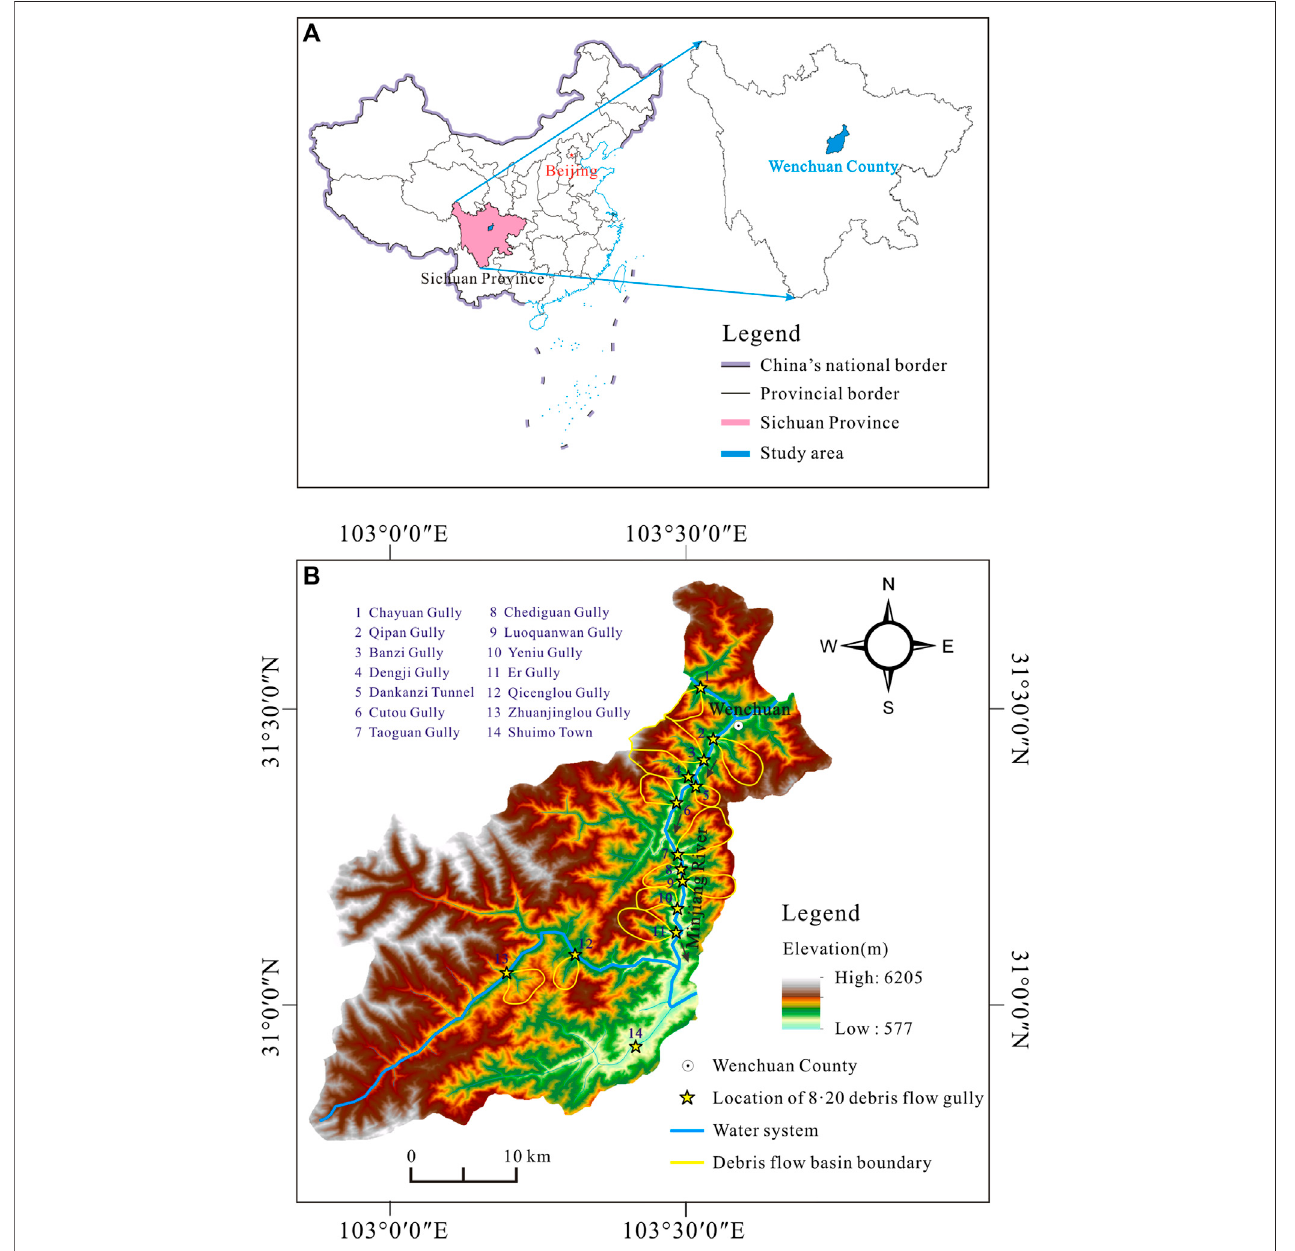
FIGURE 2 | Site location of the study area: (A) the location of the study area in China; and (B) the geomorphic map of the study area and the distribution of debris fl ows in the “ 8 · 20 ” event.